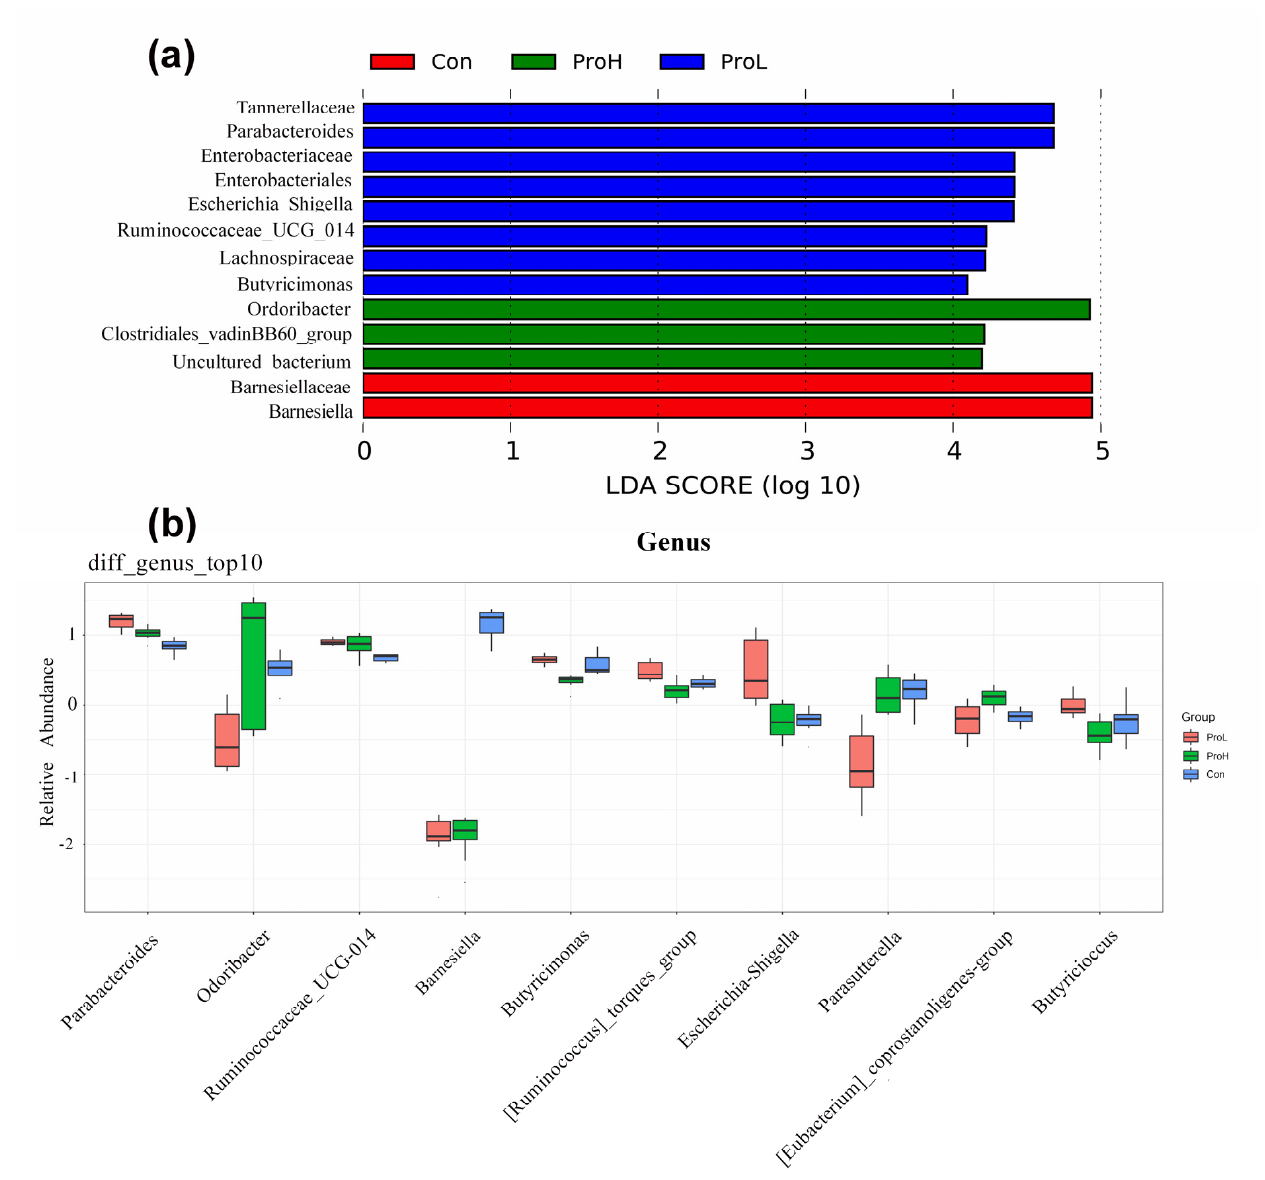
Figure 6. LEfSe analysis of the relative abundance of predominant microflora in broilers. ( a ) LEfSe analysis; ( b ) Kruskal– Wallis test of the predominant genera in all treatment groups. Con birds were fed a basal diet; ProL birds were fed a basal diet added into 10 10 probiotics cfu/kg; ProH birds were fed a basal diet added into 10 11 probiotics cfu/kg ( n = 8).